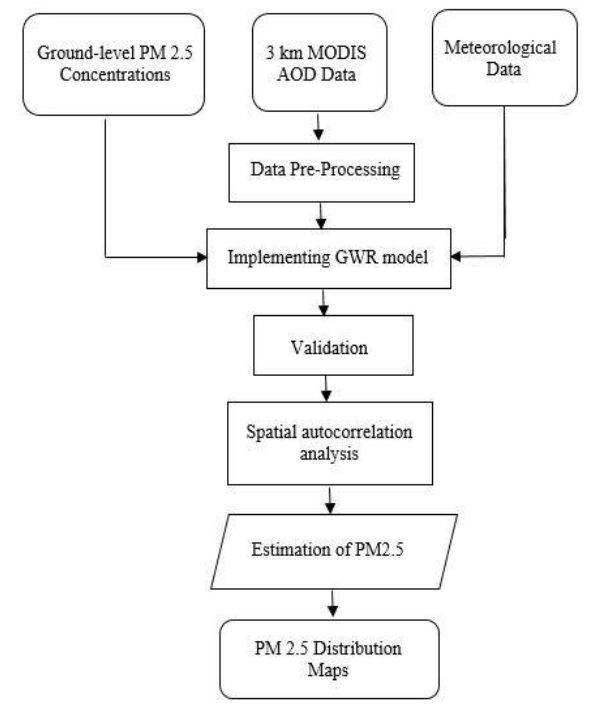
Fig. 2. Overview of the method.